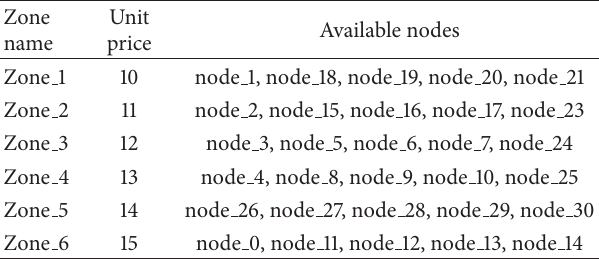
Table 1: Proposed zone payment